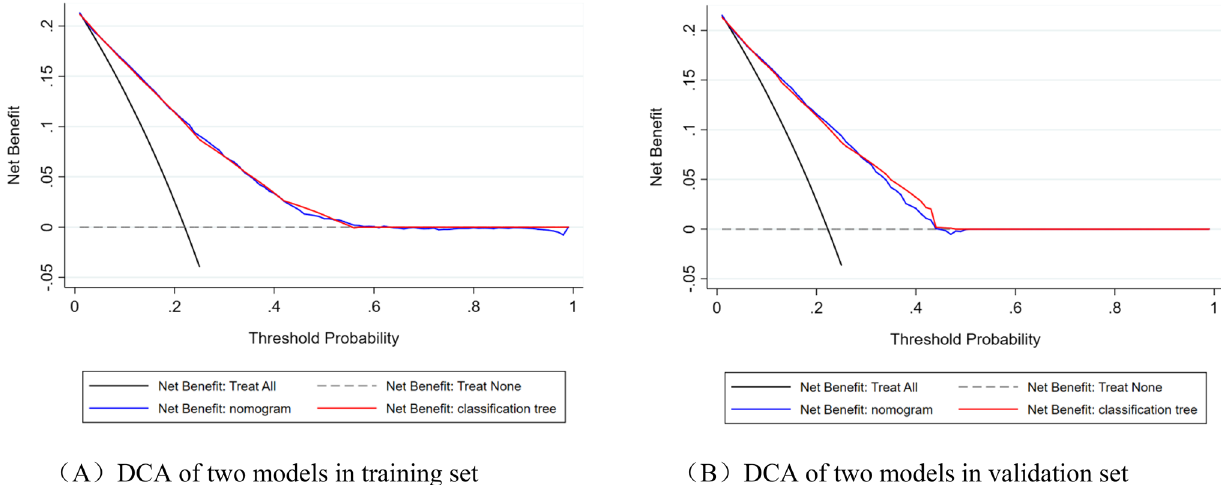
Figure 5. DCA curves of the two models in the training and validation sets. The abscissa represents the threshold probability, and the ordinate represents the net benefit after the benefit (the perceived benefit after treatment for the real patient) minus the disadvantage (the perceived harm after treatment for the fake patient). The dotted reference line indicates that all the samples were free of disease with none of them receiving any intervention, and the net benefit was 0; the black reference line indicates that all of the samples were treated for the disease, and the net benefit is represented by the backslash of the slope. The further the model curve is away from the two reference lines, the better the clinical utility of the graph. The figure was created by using STATA (version 15.1), URL: https:// www. stata.